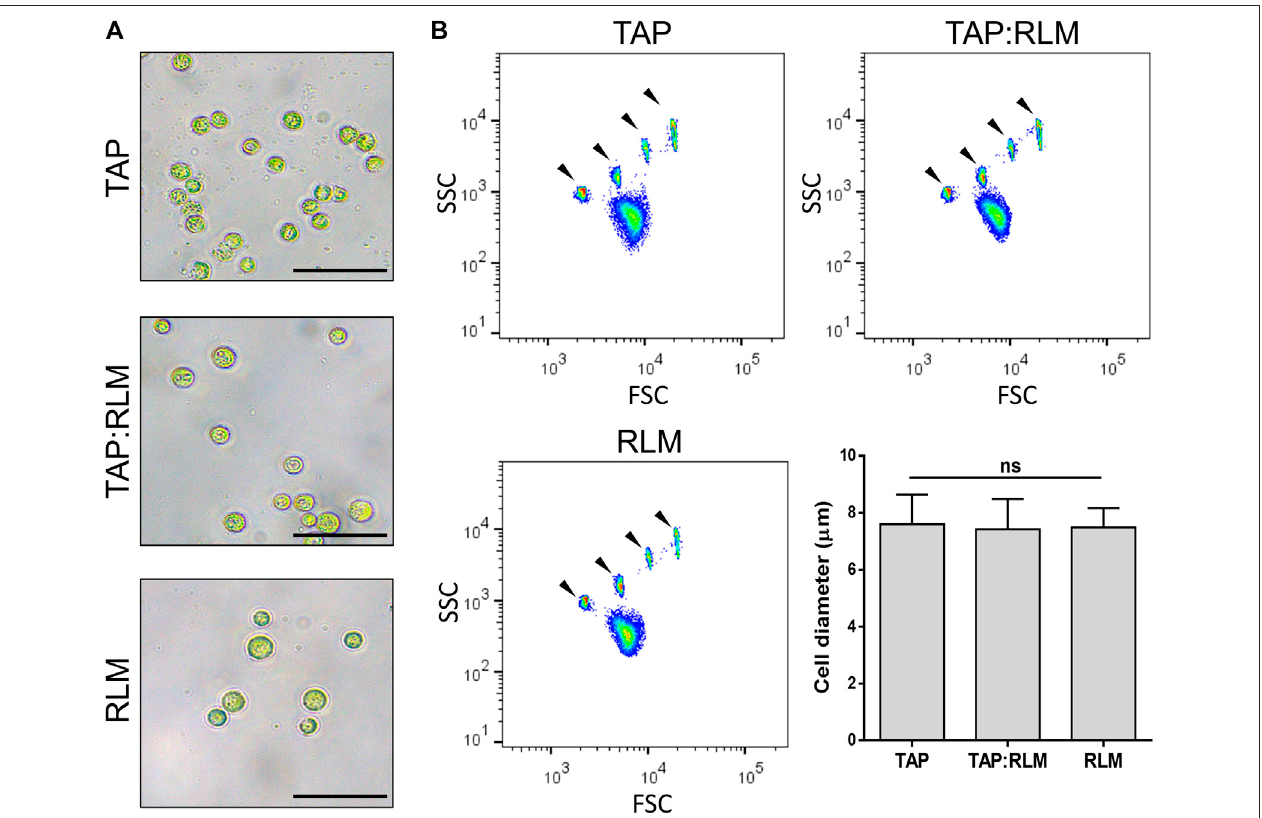
FIGURE2| Morphologyof C.reinhardtii inRLM. C.reinhardtii wereincubatedfor24 hintheirculturemedia(TAP),astandardsolutionfororganpreservation(RLM) or amix of both in a1:1 ratio (TAP:RLM). Morphology (A) and size (B) of the microalgae were not affected by the media. Arrow heads indicate size marker beads of 4, 6, 10, and 15 µm in diameter, from left to right. Scale bars represent 25 µm. Data are expressed as mean ± SD; N (cid:2) 3; ns: non-signi fi cant (one-way ANOVA